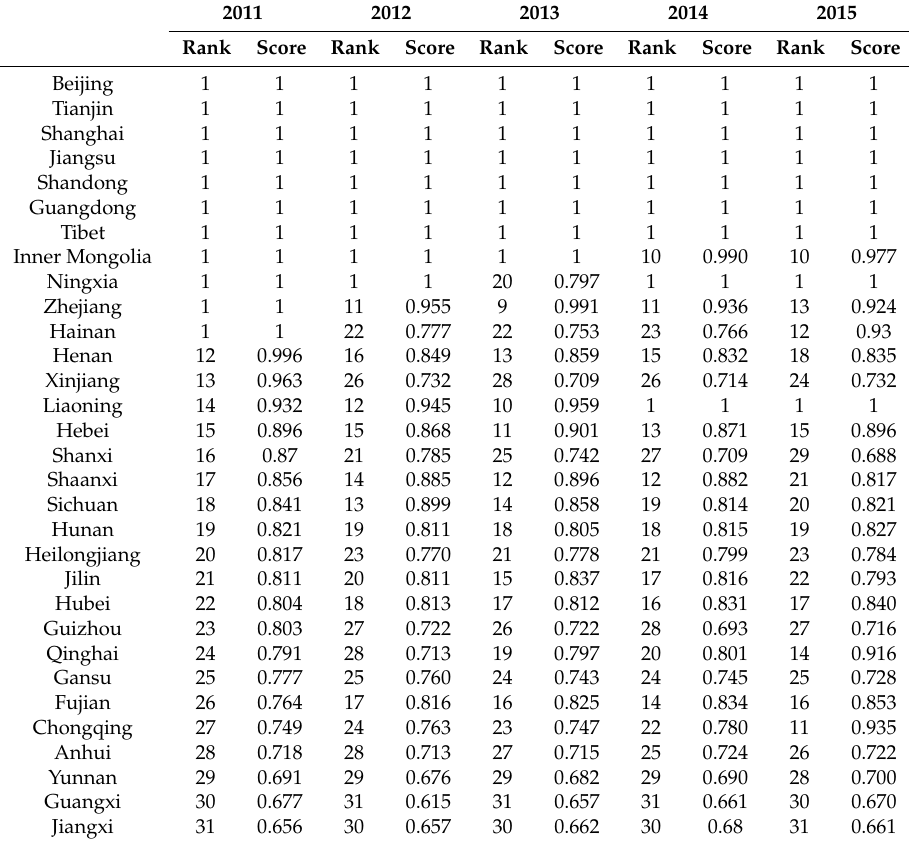
Table 5. Rank of 31 regions in China from 2011 to